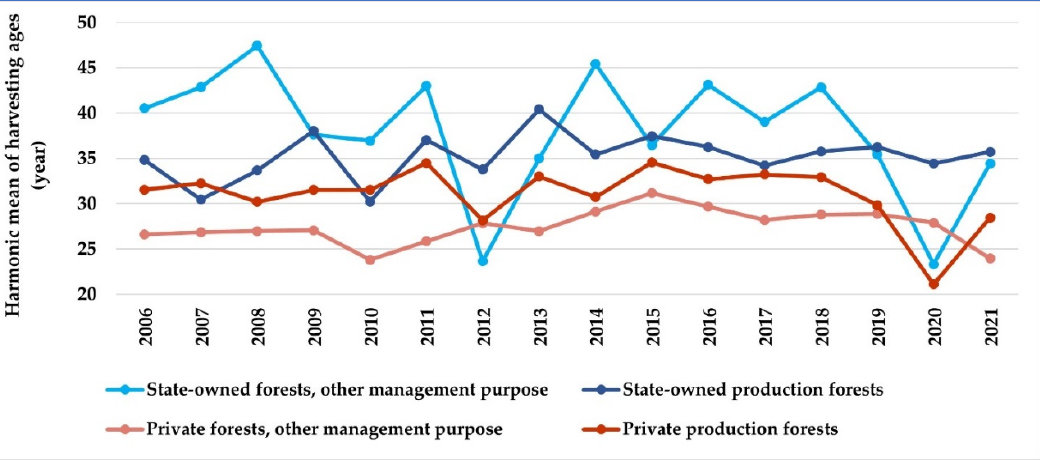
Figure 8. Harmonic mean of harvesting ages (weighted by the area under harvest) of indigenous poplar ( Populus ) stands in the period between 2006 and 2021 grouped by management purpose and ownership.